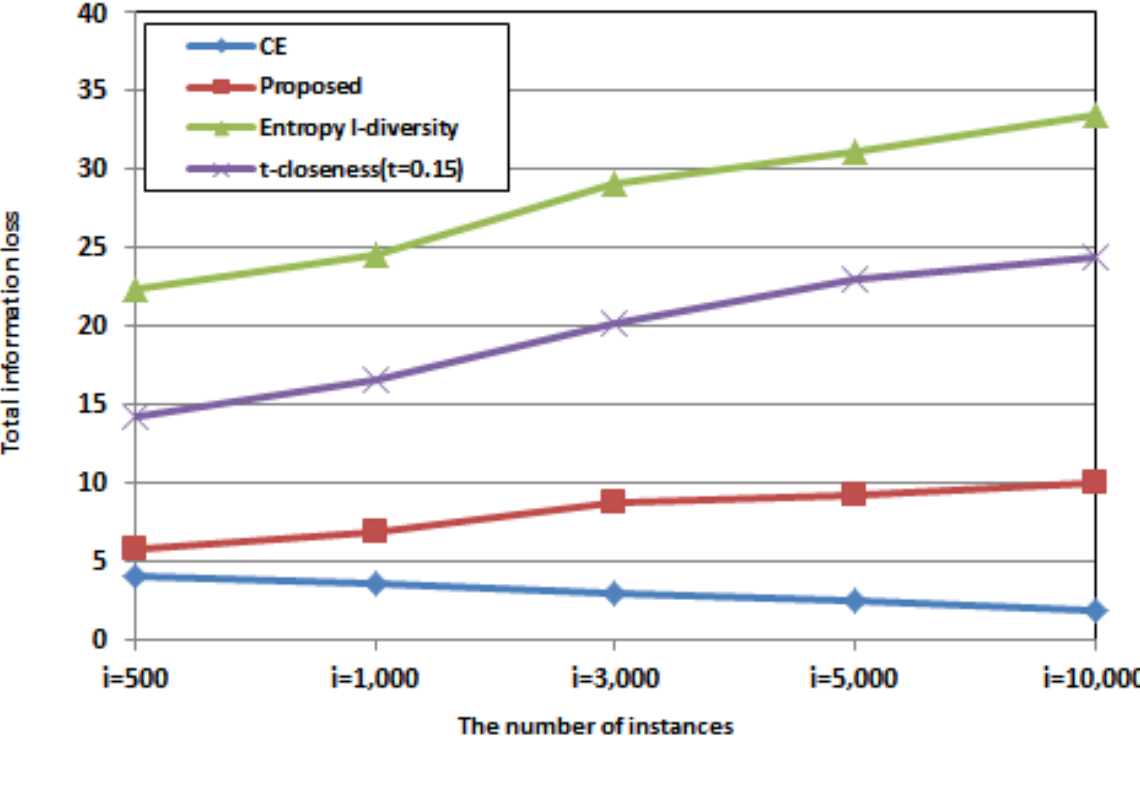
Figure 4. Comparison of total information loss with respect to the number of